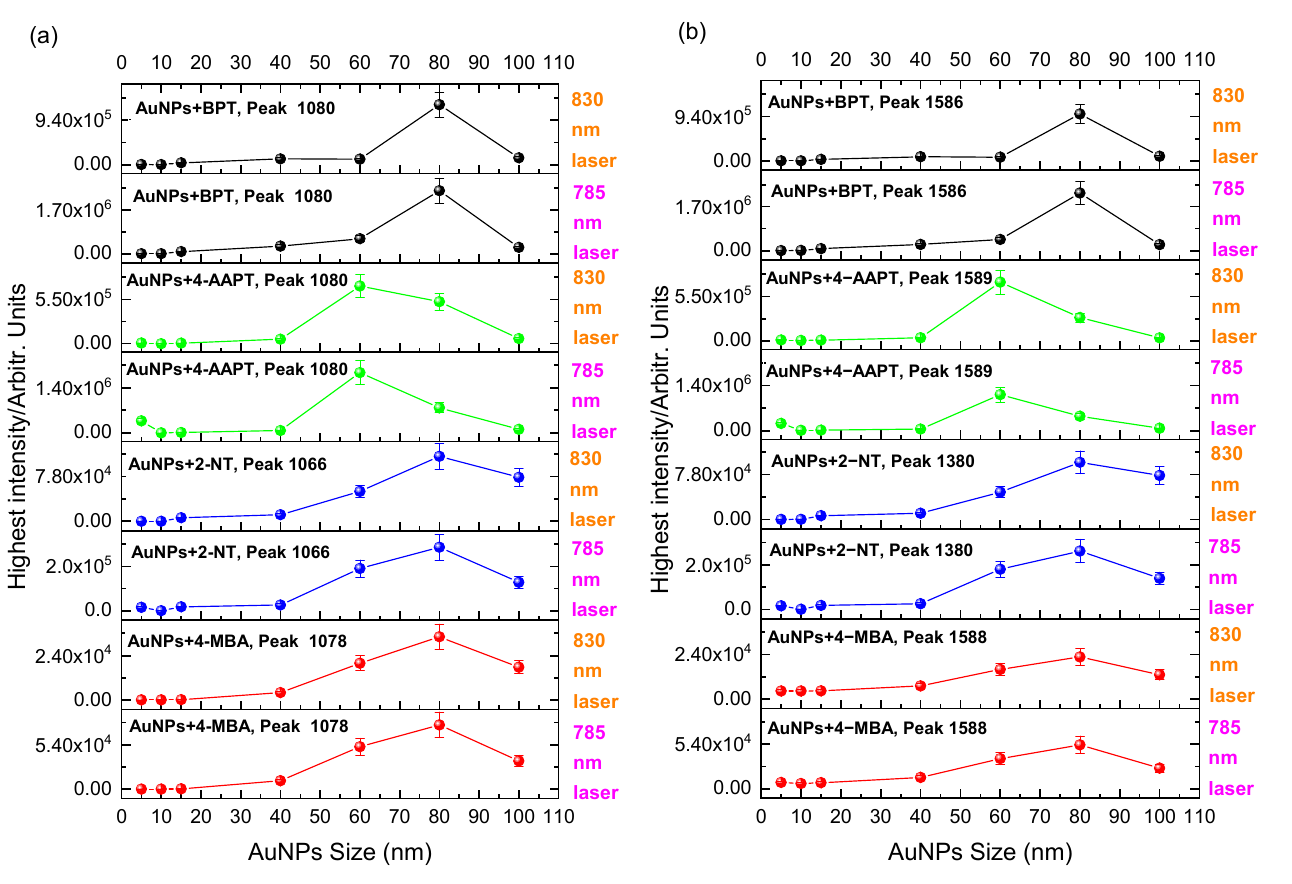
Figure 9. Plot of the intensity (height) of the two main peaks at ( a ) lower and ( b ) higher wavenumbers for labeled AuNP solutions vs. NP size at 785 nm and 830 nm excitation.